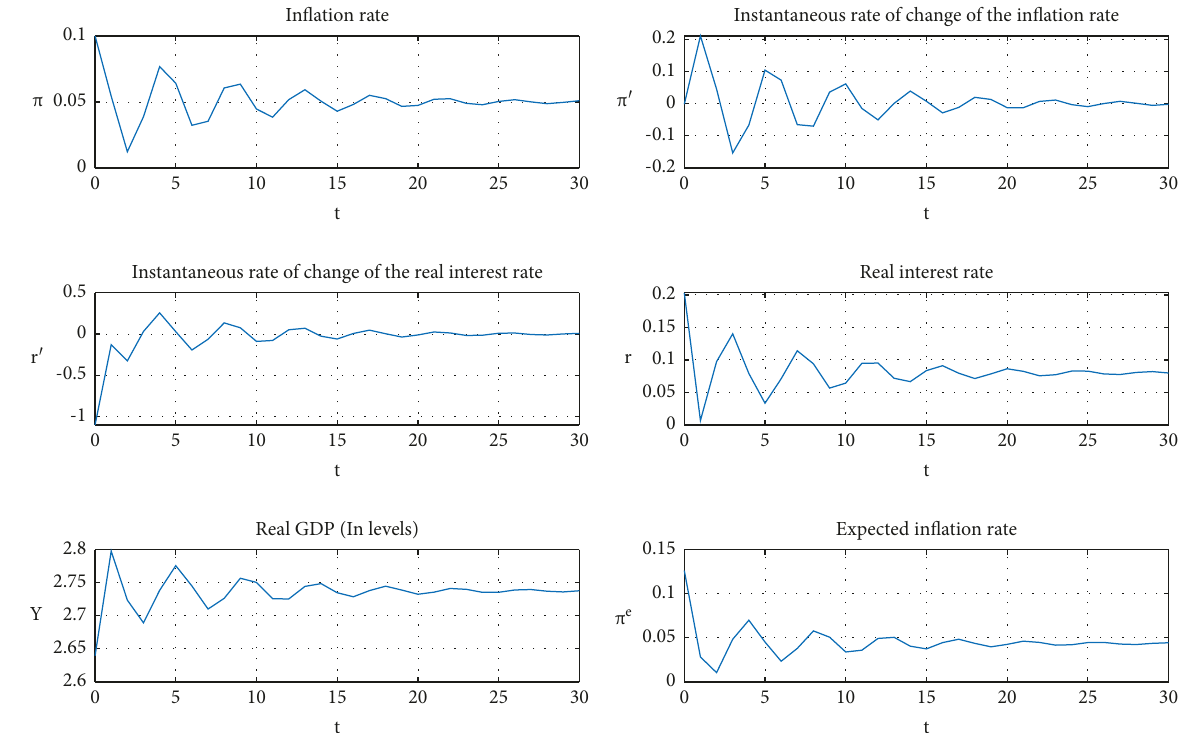
Figure 12: Time paths of the interest rate, real GDP, inflation, expected inflation, and instantaneous rates of change of the interest rate and inflation.